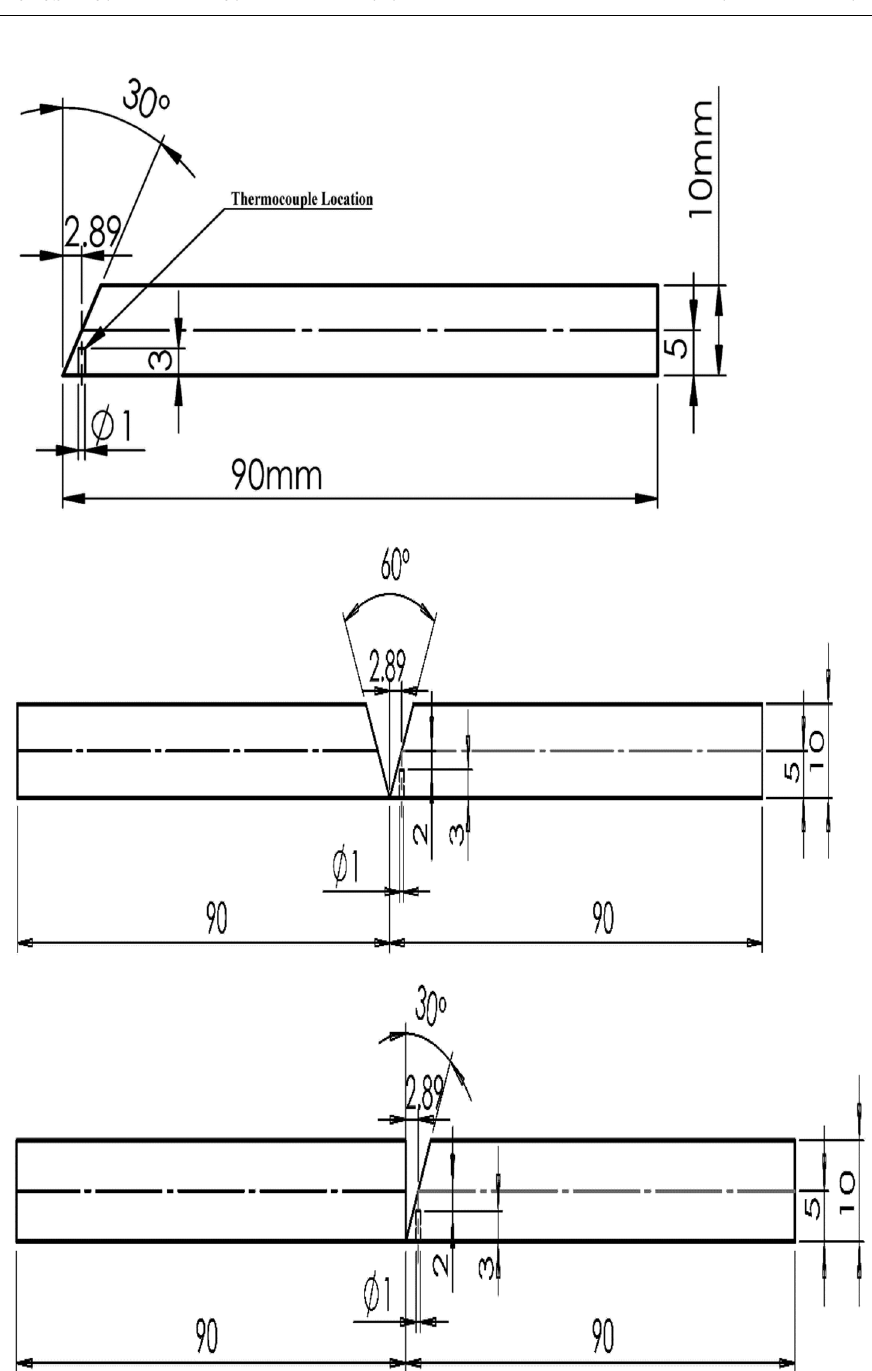
Fig. 1 Schematic drawing of edge preparation showing thermocouple